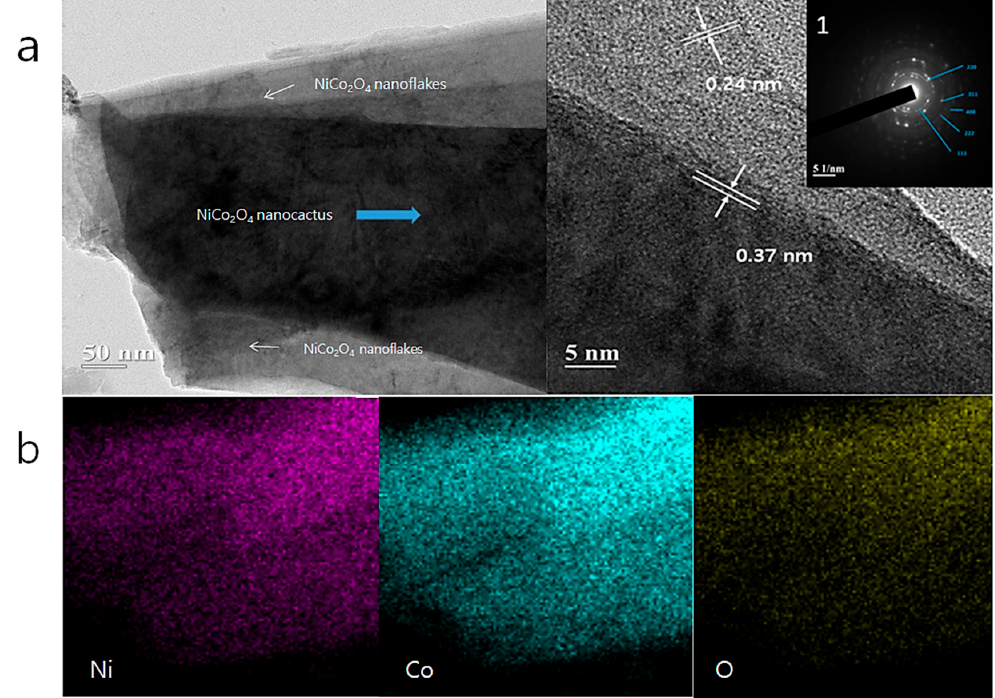
Figure 4. ( a ) TEM image and HRTEM image of individual NiCo 2 O 4 @NiCo 2 O 4 hierarchical nanostructures and (a1) inset show the selected area electron diffraction (SAED) and ( b ) corresponding EDS mapping results.